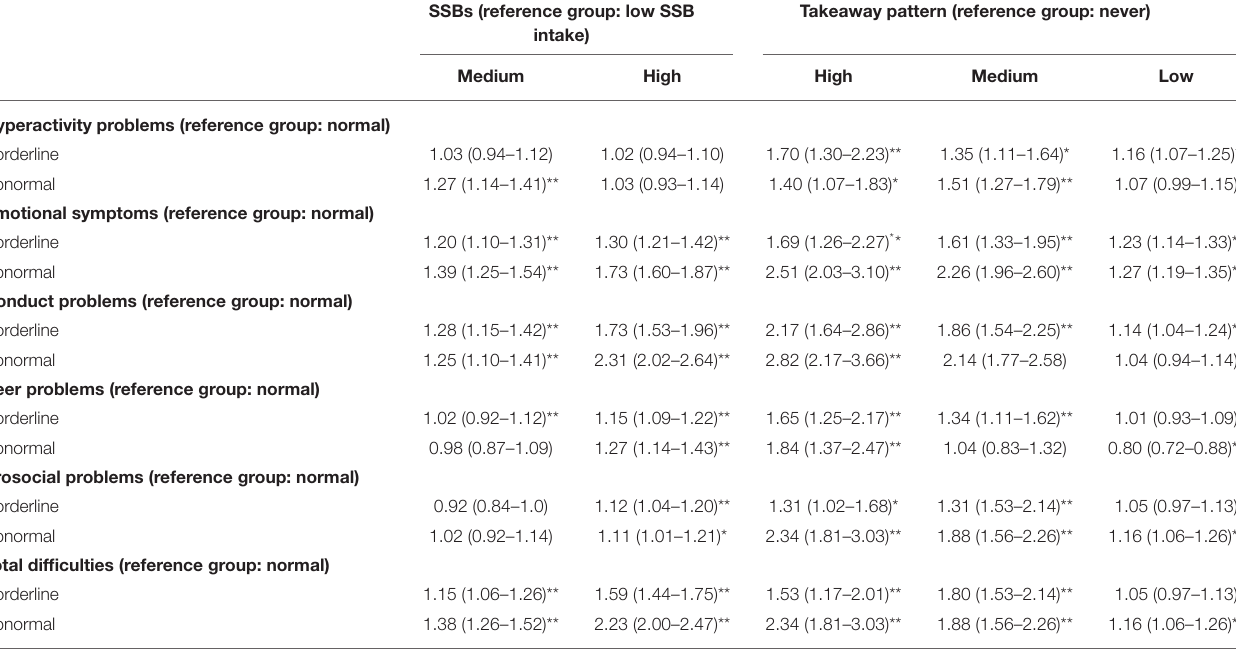
TABLE 4 | Individual effects of sugar-sweetened beverages (SSBs) and takeaway patterns on psychological and behavioral problems. SSBs (reference group: low SSB